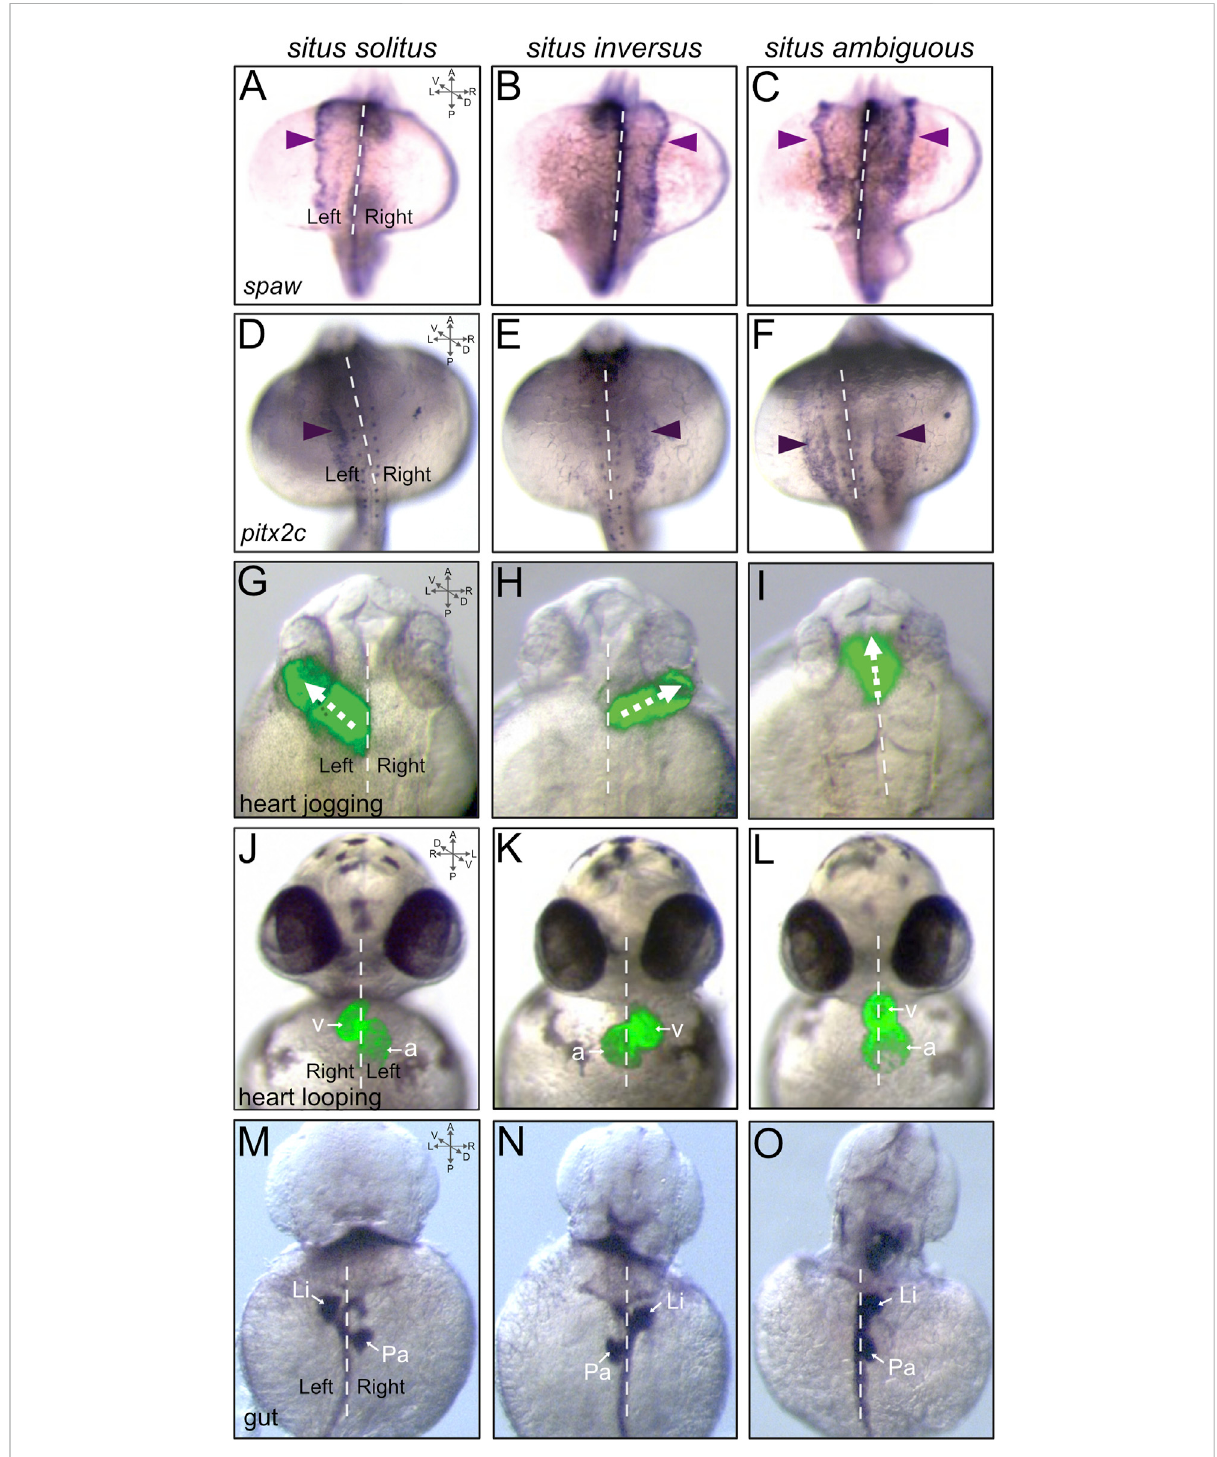
FIGURE 3 Asymmetricmarkersandlateralitydefectsinthezebra fi shembryo. (A – F) DorsalviewsofRNA insitu hybridizationsof spaw expressionatthe18- somite stage (A – C) or pitx2c expression at the 20-somite stage (D – F) . Typical asymmetric expression ( situs solitus ) occurs in left lateral plate mesoderm [arrowhead in (A,D) ]. Defects in LR patterning include right-sided [ situs inversus ; arrowhead in (B,E) ] or bilateral [ situs ambiguous ; arrowheads in (C,F) ] expression. (G – L) Visualization of heart jogging at 26 hpf (G – I) and heart looping at 48 hpf (J – L) in living transgenic Tg(myl7:GFP) (Huang et al., 2003) embryos that express GFP (green) speci fi cally in cardiomyocytes. GFP fl uorescence images are superimposed on